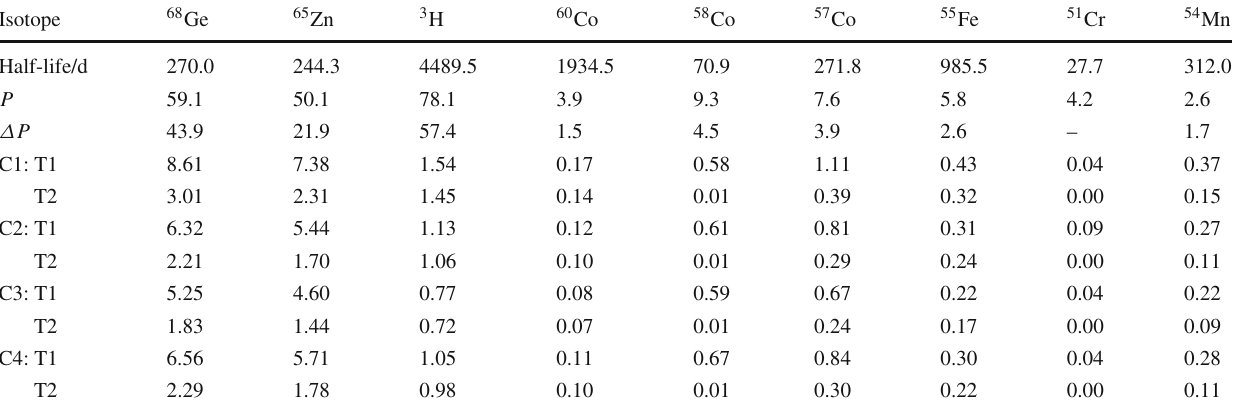
Table 4 Activities A (unit: decays kg − 1 d − 1 ) of relevant cosmogenic radioisotopes in natural Ge included in the Conus HPGe diodes for the points in time T1 = April 1, 2018 (beginning of Run -1) and T2 = May 16, 2019 (beginning of Run -2). The predictions are based on known activation and ‘cooling down’ periods during detector